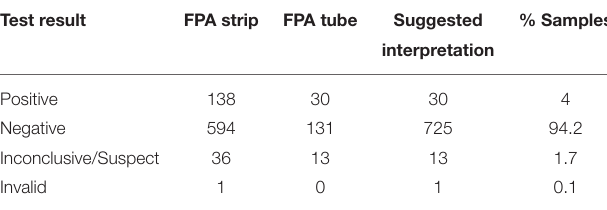
TABLE 4 | Test results and suggested interpretation of smooth strain Brucella tests for 769 retrospective samples.